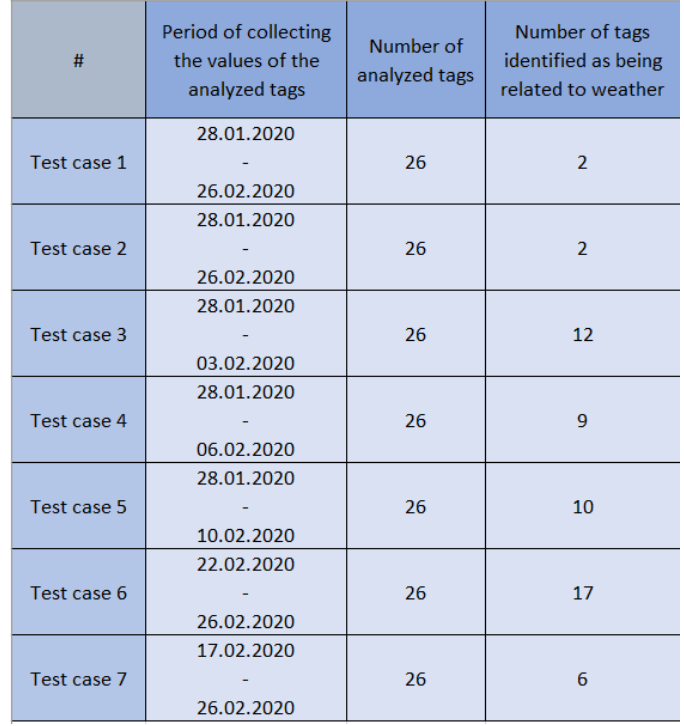
Figure 7. The 7 test cases considered for validation of the implementation.